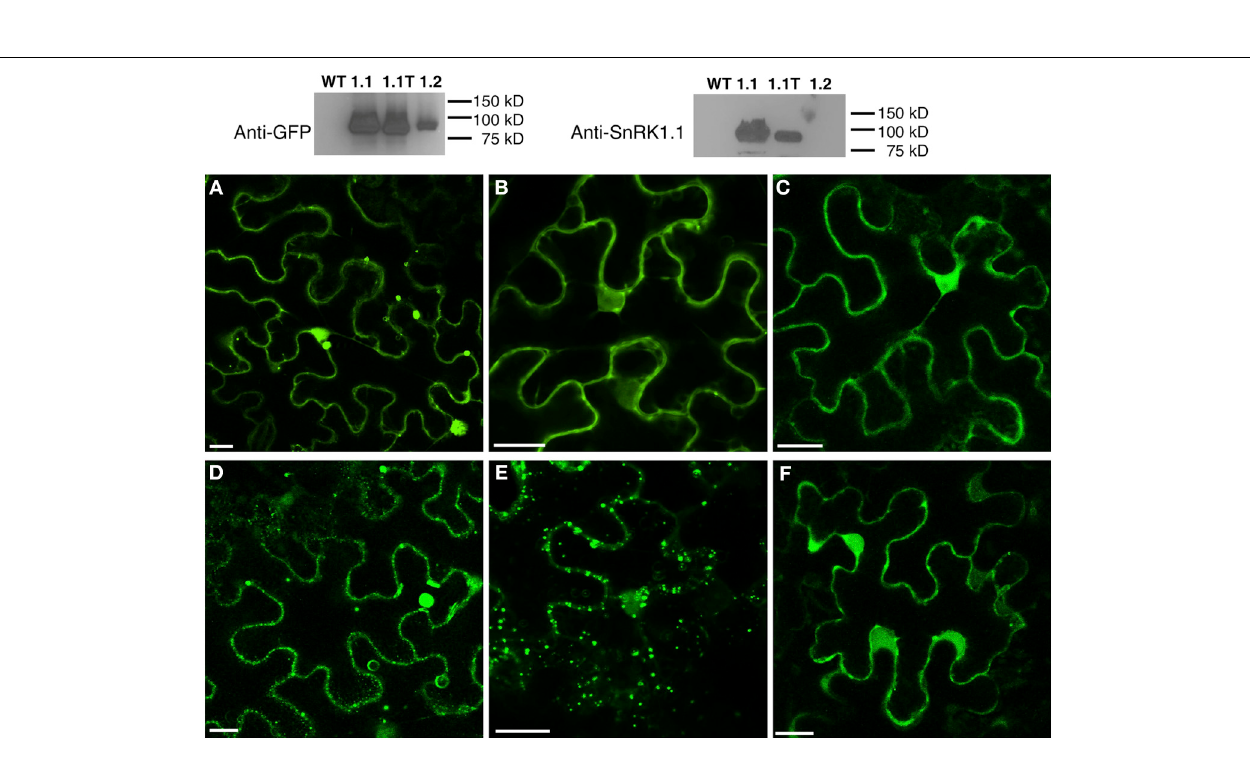
FIGURE 10 | Subcellular Location of SnRK1.1-, SnRK1.1T-, and SnRK1.2-GFP Proteins. Upper: Leaves of N. benthamiana